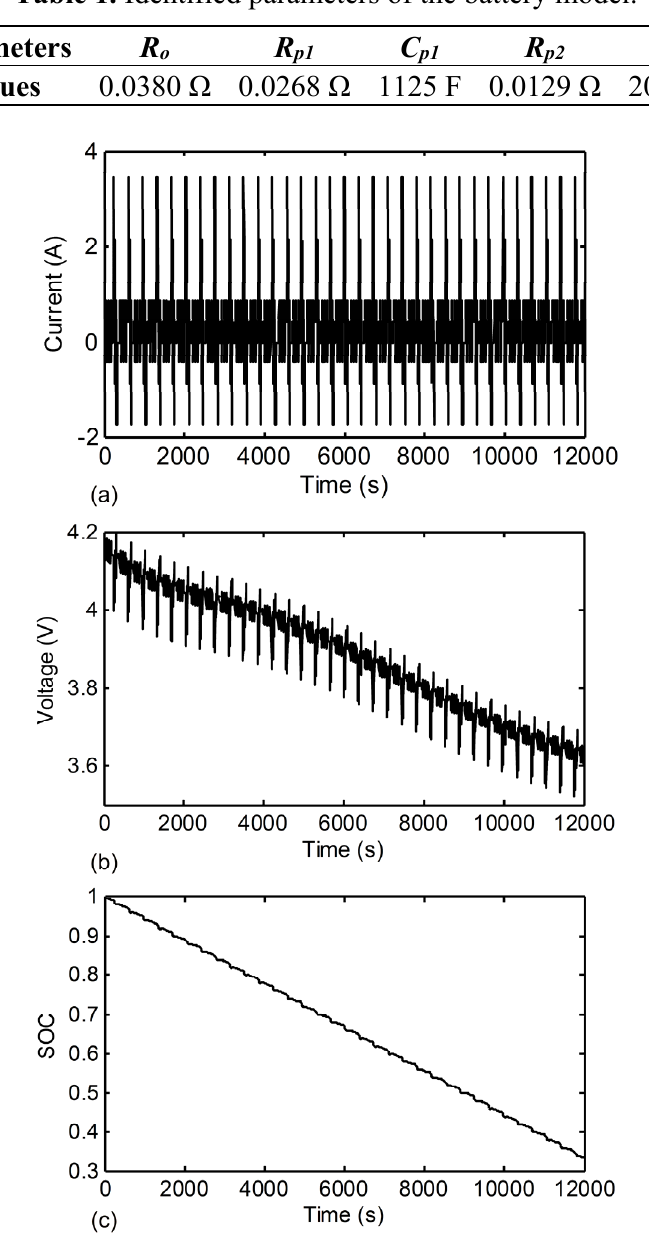
Figure 4. Sample data under DST (Dynamic Stress Test) cycles: ( a ) current; ( b ) voltage; ( c )